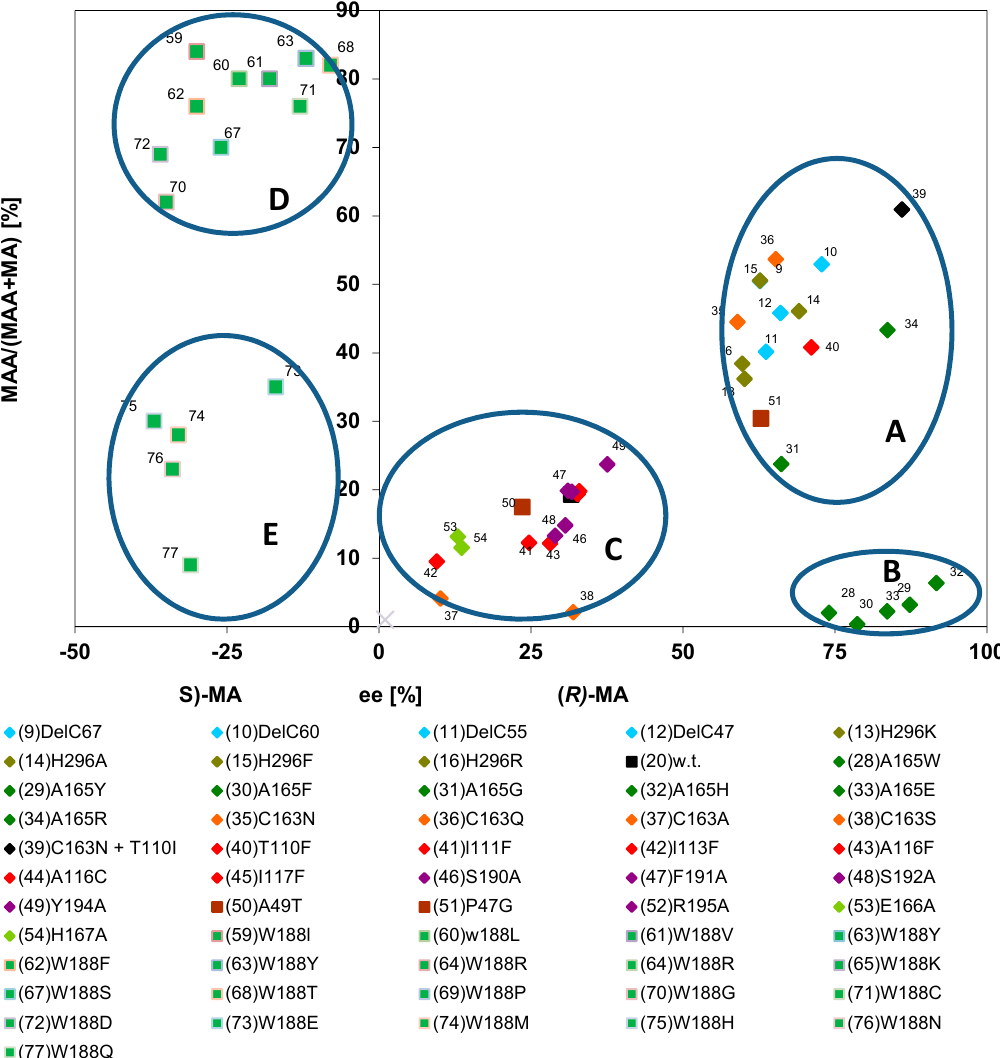
Figure 12. Correlation between the relative amounts of mandelamide formed and the ee-values of the mandelic acid produced during the conversion of ( R , S )-mandelonitrile. The data were taken from previous publications (see Figure